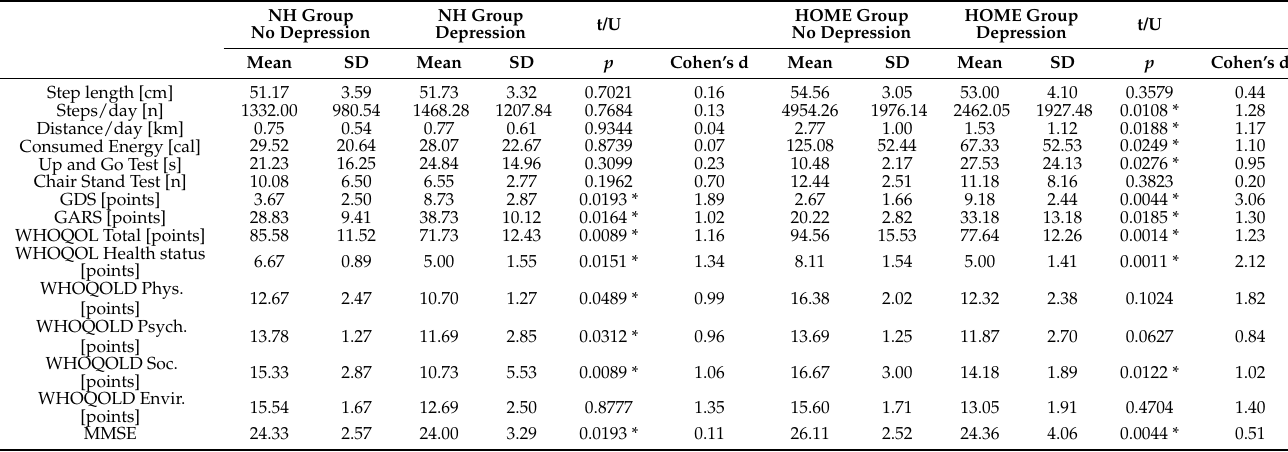
Table 4. Results of the physical activity, the functional physical fitness test and the psychophysical self-assessment questionnaires for subjects with and without